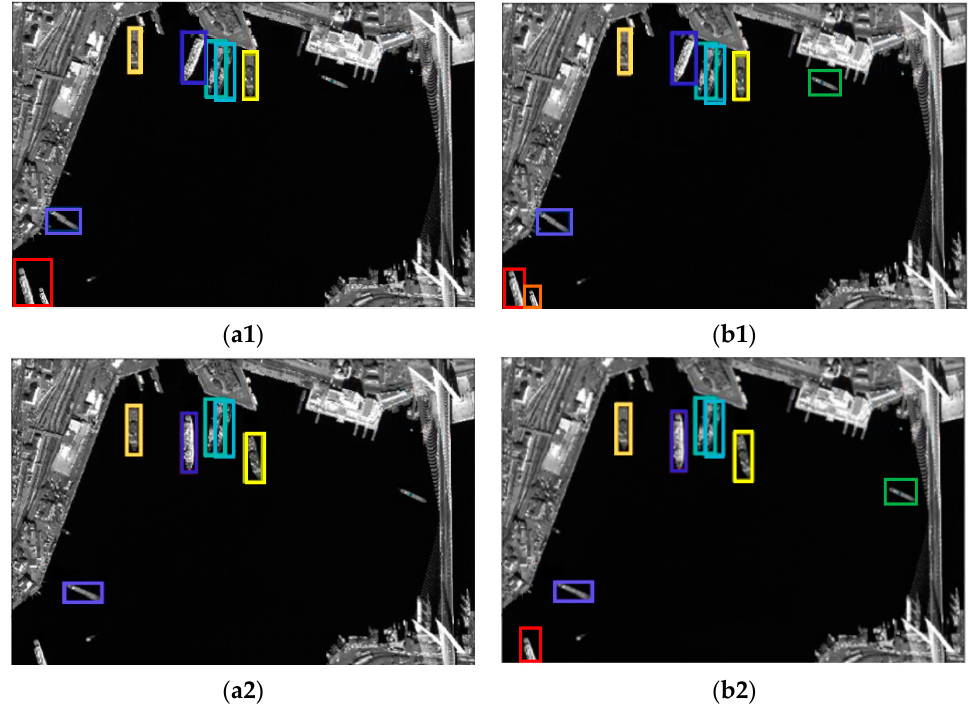
Figure 7. The results showing the detection of different algorithms on the dataset: ( a1 , a2 ) the YOLOv3 model; ( b1 , b2 ) the proposed model in this paper.